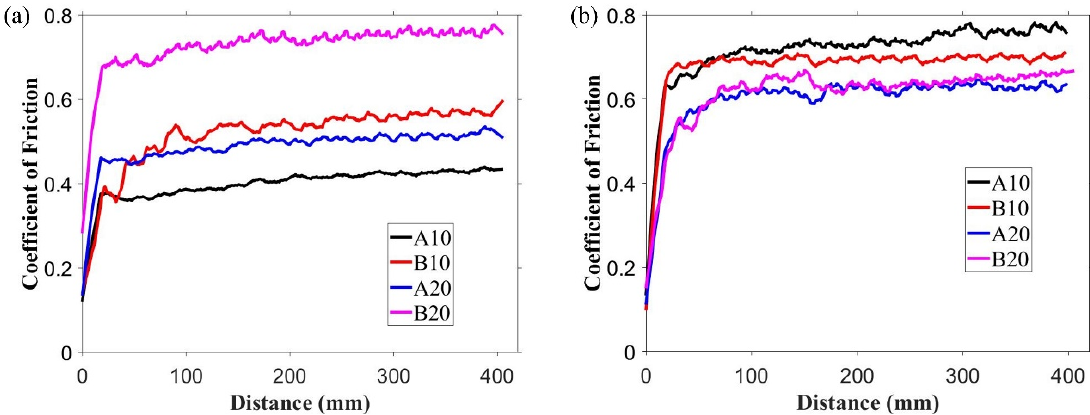
Figure 6. Coefficient of friction (COF) variation over the sliding distance against ( a ) alumina ball and ( b ) steel ball.